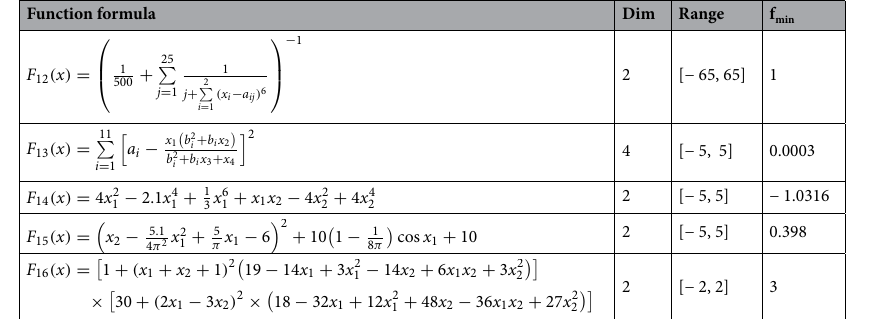
Function formula Dim